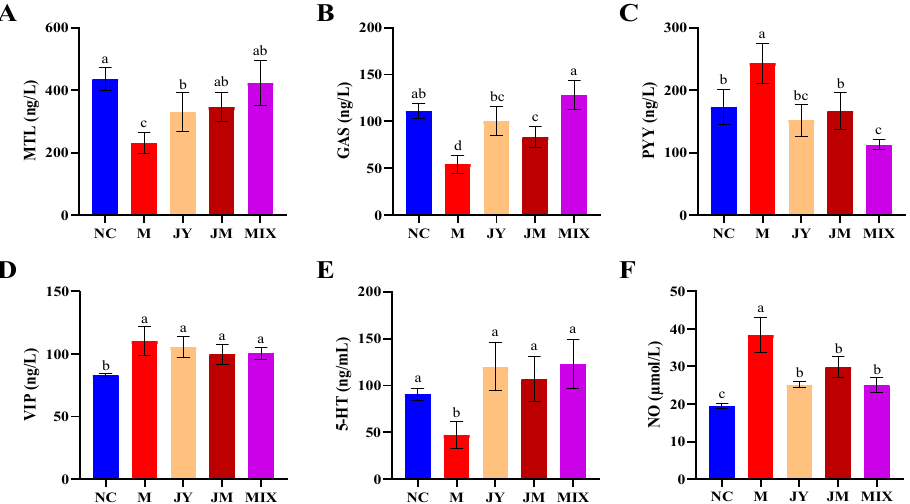
Figure 2. The contents of GI regulatory peptides and neurotransmitters in mice: ( A ) content of motilin (MTL); ( B ) content of gastrin (GAS); ( C ) content of peptide YY (PYY); ( D ) content of vasoactive intestinal peptide (VIP); ( E ) content of 5-hydroxytryptamine (5-HT); ( F ) content of nitric oxide (NO). Different letters (a, b, c and d) denote significant differences between different groups of mice ( p < 0.05). NC stands for the normal control group, M for the model group, JY for the L. paracasei JY062 group, JM for the L. gasseri JM1 group, and MIX for the combination